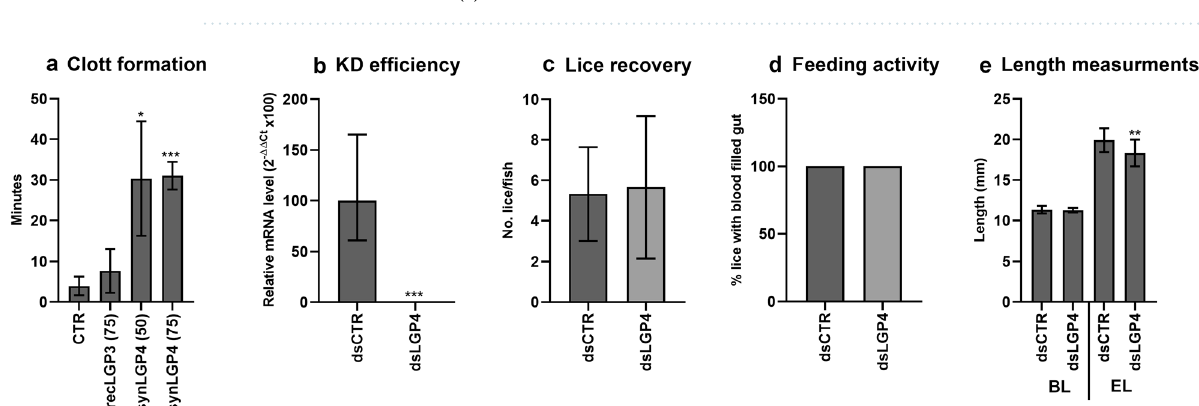
Figure 6. Relative transcript level (2 −∆∆Ct ± SD) of selected Atlantic salmon immune gene transcripts in head kidney leucocytes after a 4-h stimulation with recombinant LsLGP3 (recLGP3) (N = 3). Three quantities of recLGP3 were applied, 150, 112.5 and 75 μg/well. The immune gene expression in control (ctr), LPS, and recLGP3 treated leucocytes were related to elongation factor 1 alpha ( elf1α ) (∆Ct), using the expression in control cells as calibrator (∆∆Ct). Significant difference (p ≥ 0.05) between ctr and recLGP3 treated leucocytes are denoted with an asterisk (*).